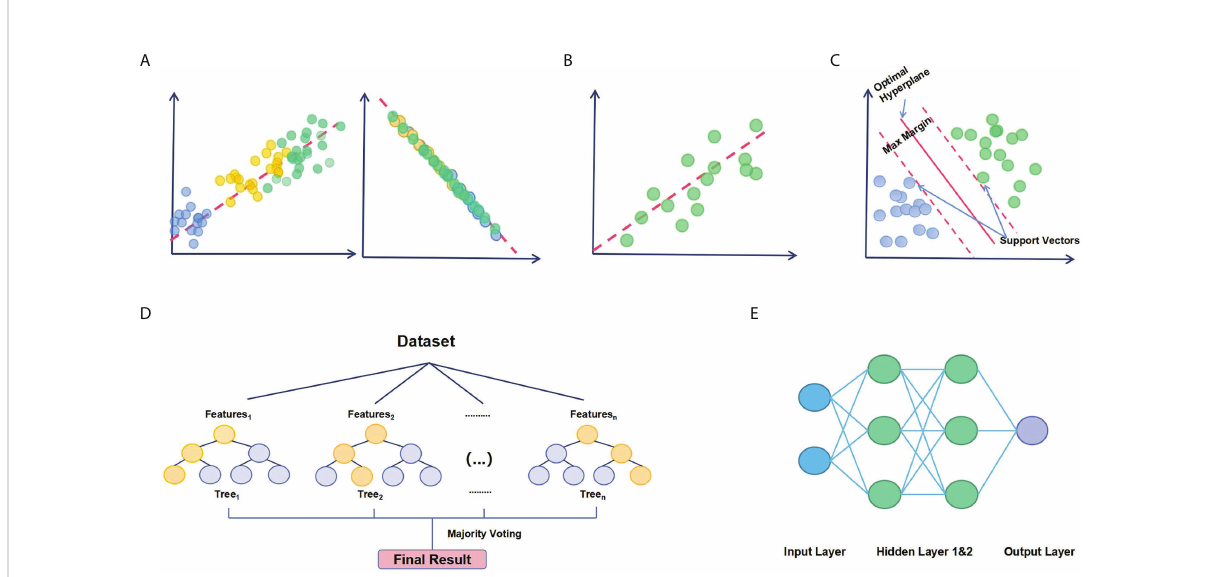
FIGURE 2 Basic principles of standard ML algorithms. (A) PCA reduces the dimensionality of a data set consisting of plenty of interrelated variables. (A) illustrates a series of data points viewed from another angle with approximately the same value on that dimension. It shows that the distinction between the data points can be represented by a principal component. (B) Regression analysis determines the relationship between factors and disease outcomes or identi fi es relevant prognostic factors for diseases. (B) illustrates regression estimating a mathematical formula that relates input variables to the output variable. (C) SVM generates a hyperplane in higher-dimensional feature space and maximizes the margin of error to select the best hyperplane. The best hyperplane would serve as a decision boundary for classi fi cation. (D) RF model ensembles a large number of small decision trees. Each tree is capable of making an individual prediction. (E) Neural networks tend to resemble the connections of neurons and synapses in human brain. The input data is assigned initial weights and transferred to output layers for classi fi cation. Hidden layers would tune the initial wrights to minimize the neural network ’ s prediction